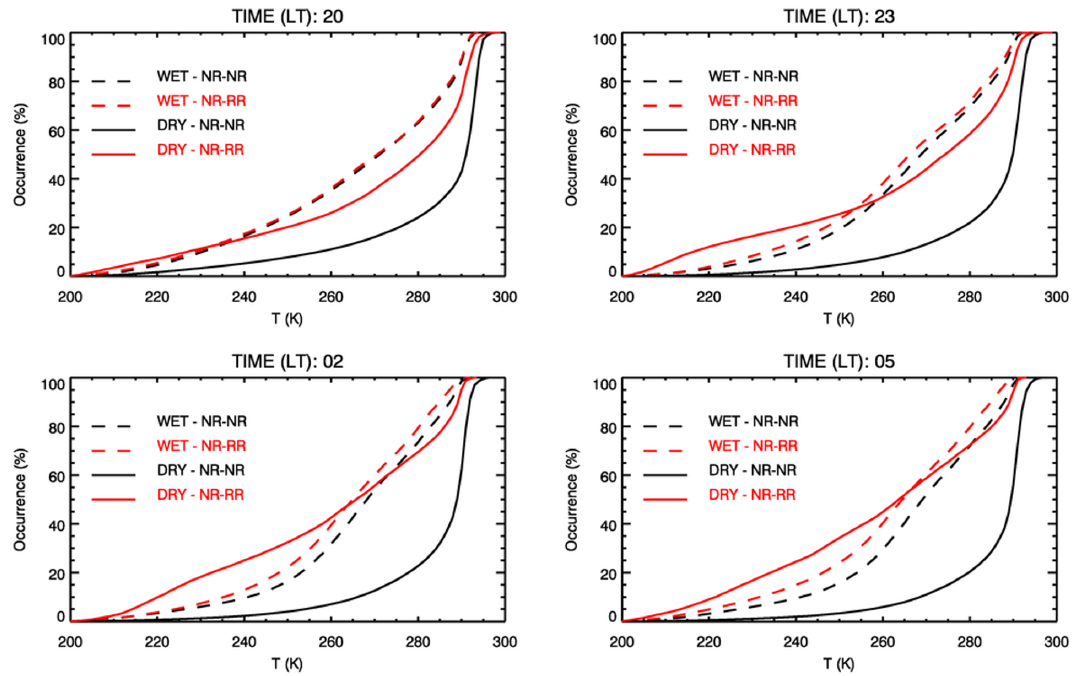
Figure 15. Cumulative distribution functions (grouped in 3h groups) of GOES 10.4µm brightness temperatures for dry and wet seasons and NR–NR and NR–RR transitions during the nighttime period. The time at each panel is the start time (LT).